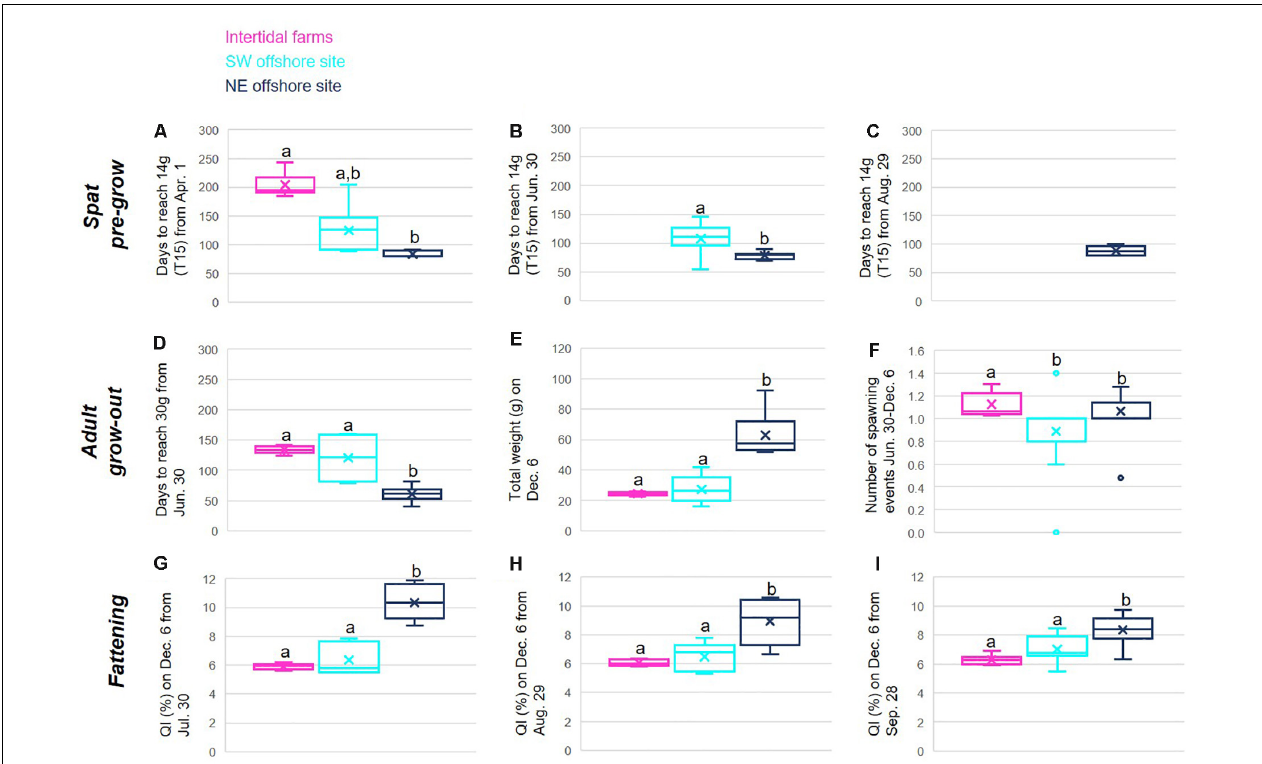
FIGURE 9 | Comparison of interannual indicator values for two hypothetical offshore sites (see Figure 1 ) (dark blue (NE) and turquoise (SW)) and existing intertidal farms (pink) for the scenarios and growth indicators detailed in Table 3 , for the spat pre-growing phase (A–C) , from an initial T6–T8 (0.5 g) size, adult grow-out phase (D–F) , from an initial T25 (14 g) size, and final fattening phase (G–I) , from an initial Calibre 3 Normale size (76 g; QI = 6%). Different letters above boxes are associated with statistically different groups (Kruskall–Wallis one-way ANOVA on ranks and Tukey test p < 0.05). Note that missing boxes associated with given sites (B,C) correspond to the target weight not being achieved for that site within the defined time